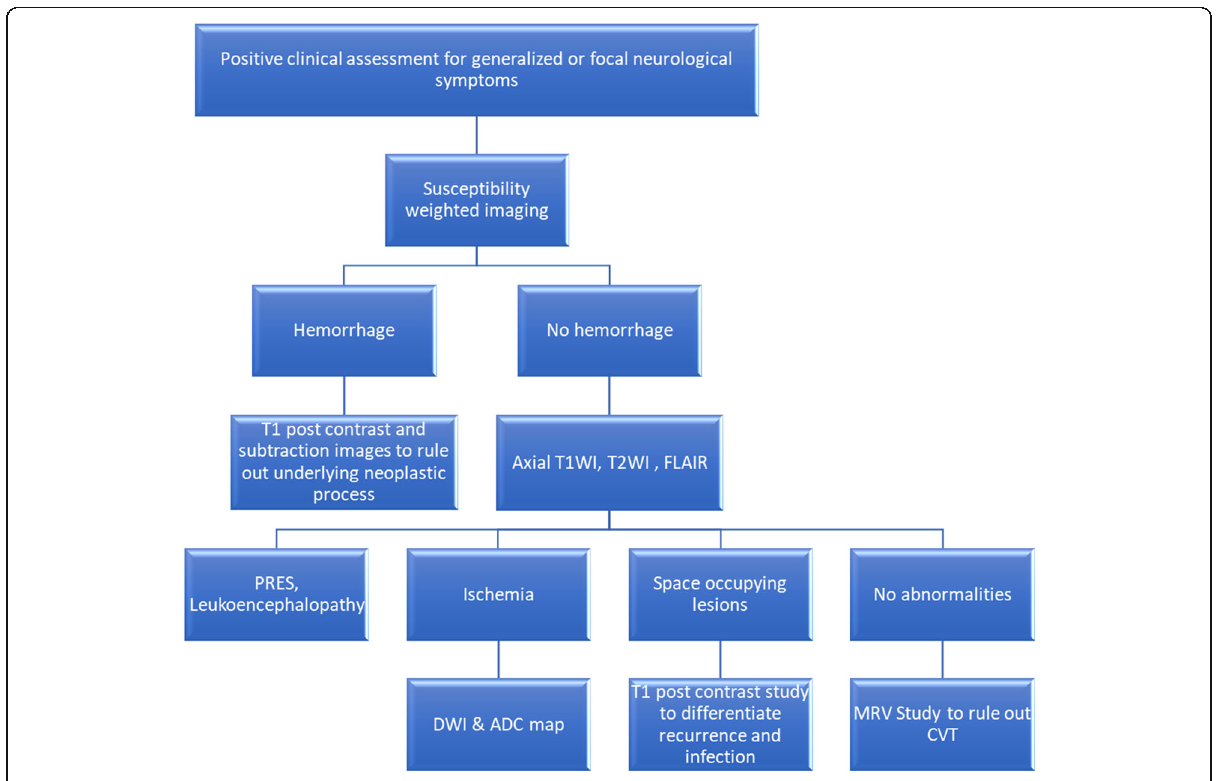
Fig. 7 Proposed imaging protocol for post-HSCT pediatric oncology patients with neurological